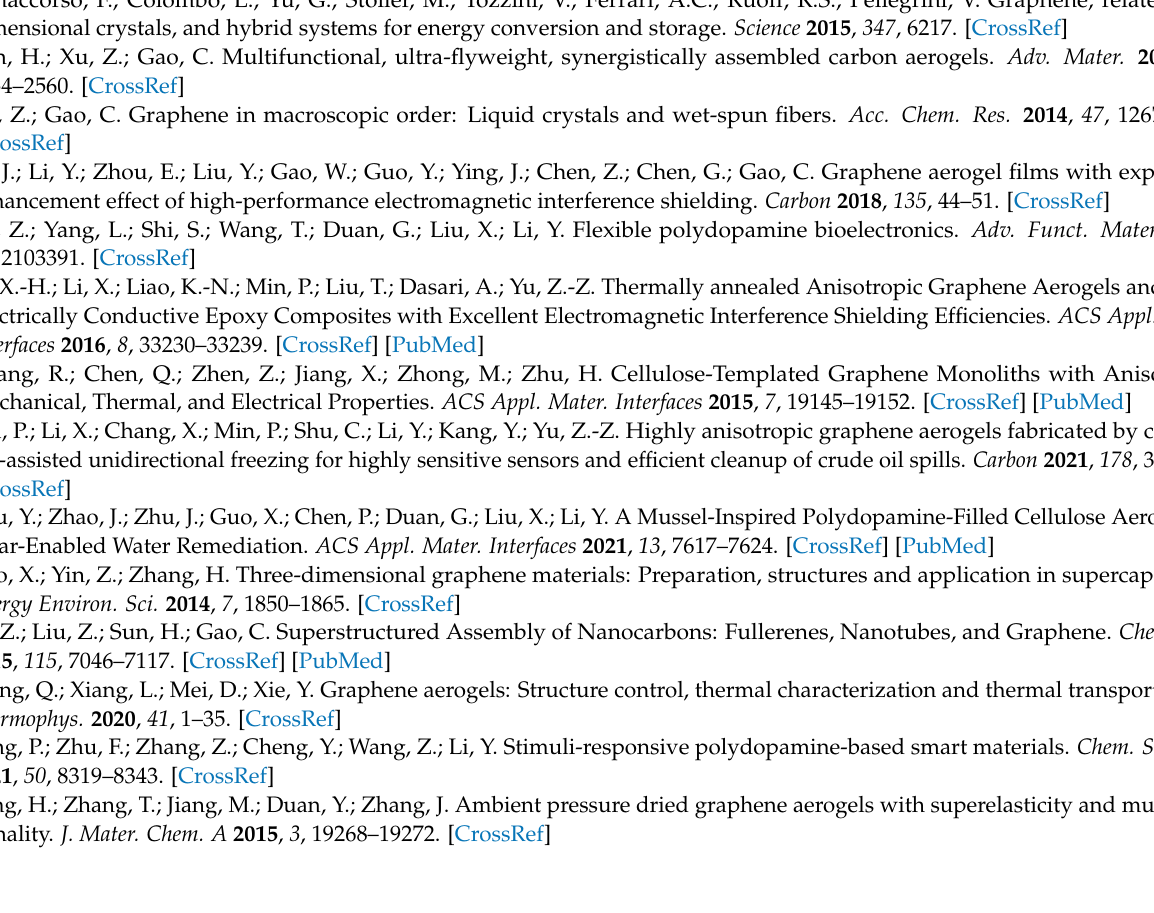
Supplementary Materials: The following are available online. Figure S1: Graphene film reduced by HI solution and Graphene film after carbonization under 3000 ◦ C with loose and porous structure, Figure S2: Cross-section of a GAF annealed at 3000 ◦ C with a loose and porous structure that made by tear opening, Figure S3: Stress-strain curves of compressed GAFs with thicknesses of 3 µ m, 5 µ m and 19 µ m, Figure S4: Cross-section of compressed GAFs that illustrates Z-shape folding formed by compression of multilayer graphene of gas chambers, Figure S5: Cross-section of a pressed graphene film with highly compacted and oriented structure, Table S1: Detailed data of Elemental analysis, XRD and Raman for GO and GAFs at the different annealing